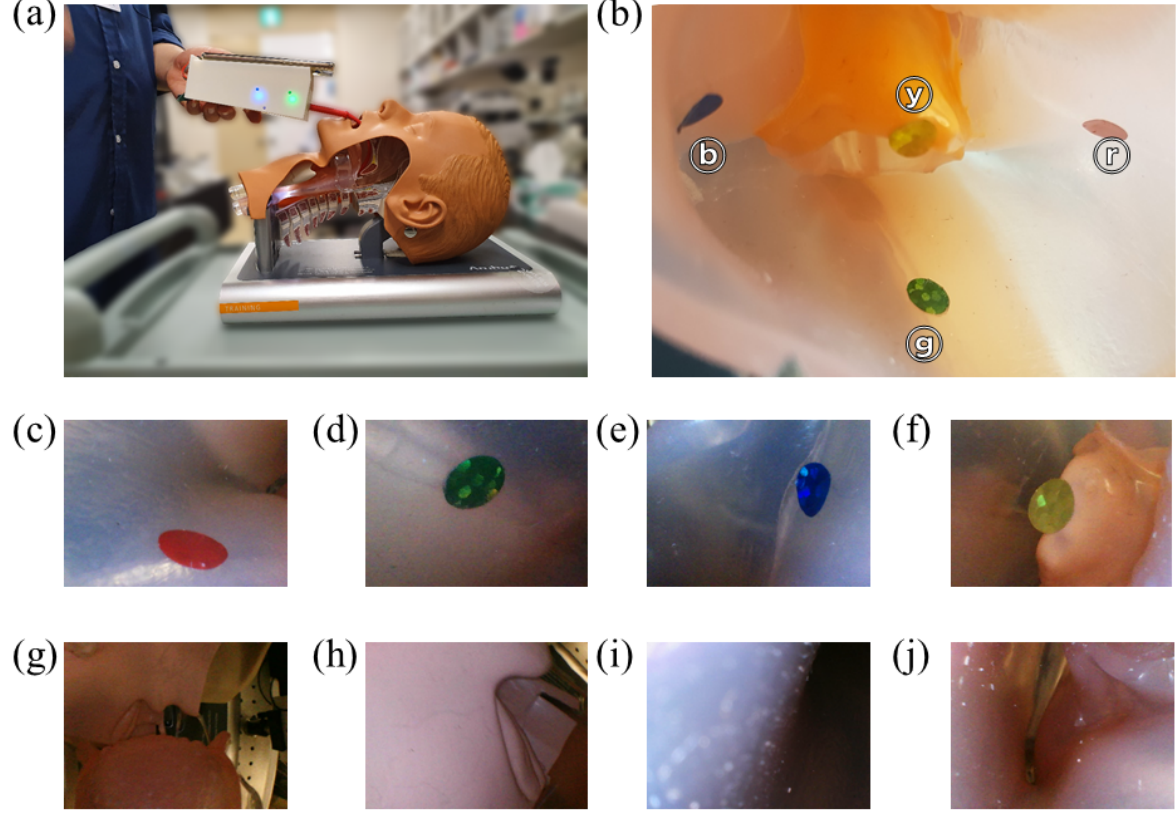
13B. The marks were in the oropharynx area: yellow, on the epiglottis; green, on the back wall of the oropharynx; and red and blue, on the right and left walls of the oropharynx, respectively. After the endoscope insertion, it was possible to